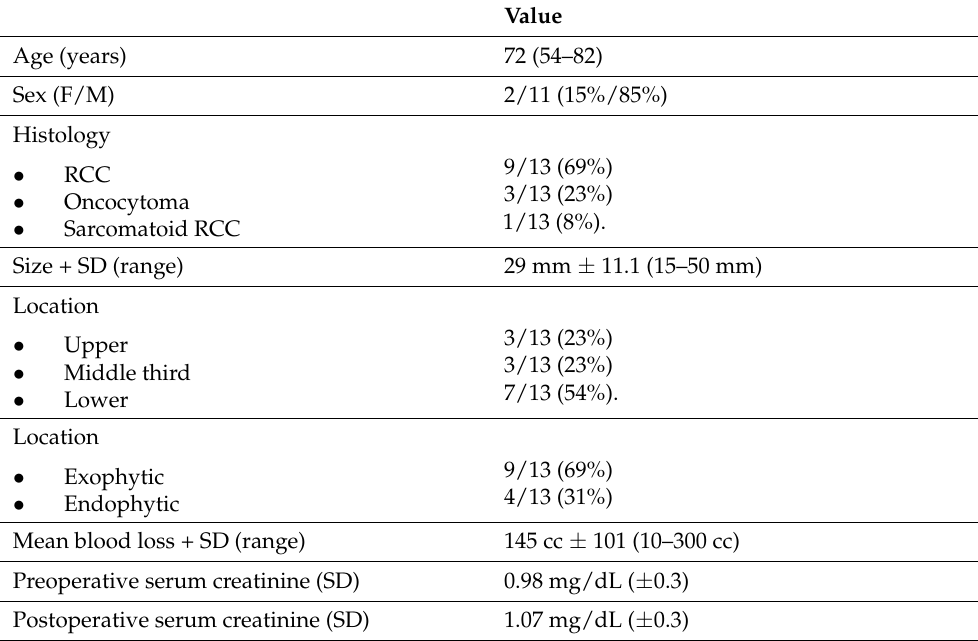
Table 1. The main characteristic of the population and measured size of the pathological